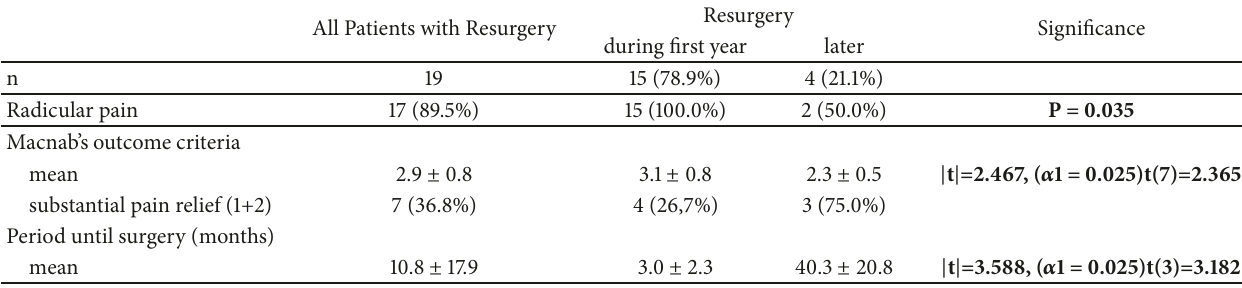
Table 2: Patient characteristics dependent on the time of resurgery and significant differences between these two groups. All Patients with Resurgery